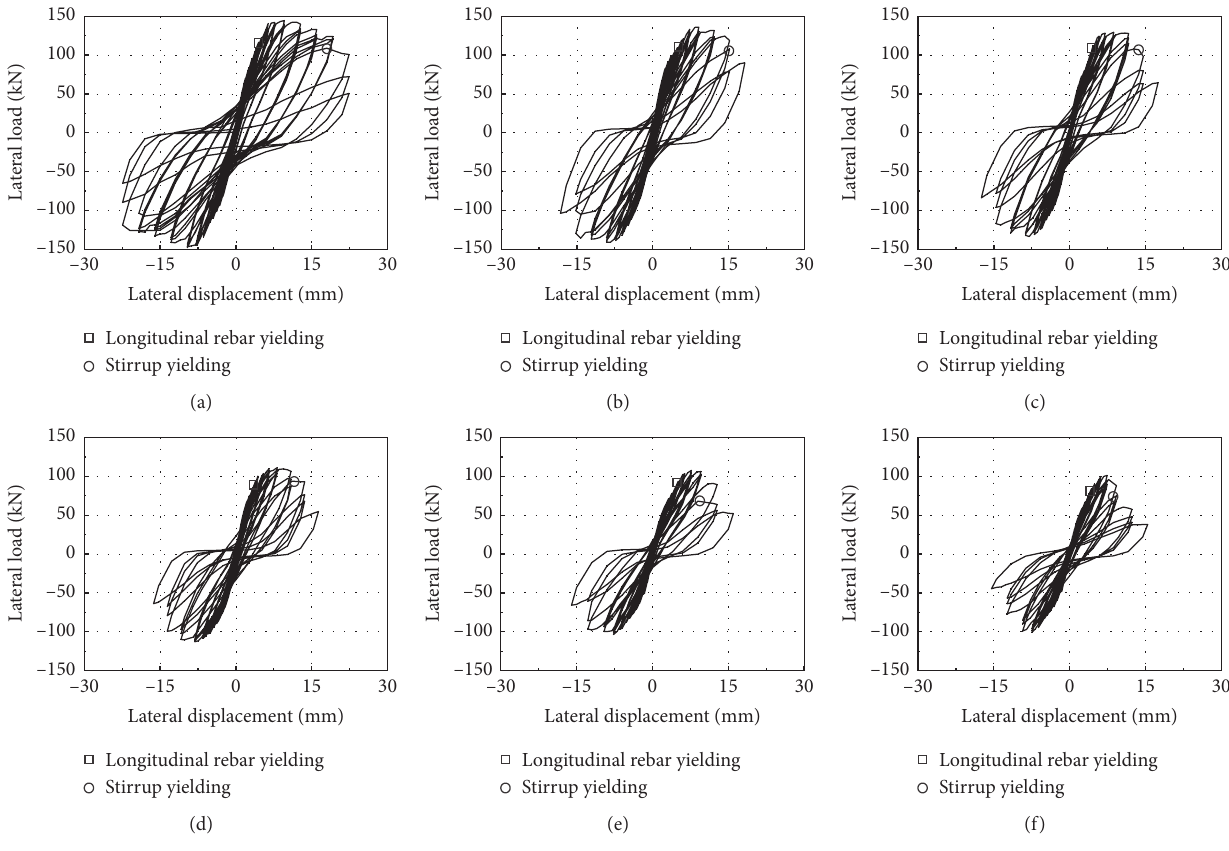
Figure 7: Hysteresis loops of the specimens: (a) SC-1; (b) SC-2; (c) SC-3; (d) SC-4; (e) SC-5; (f) SC-6.